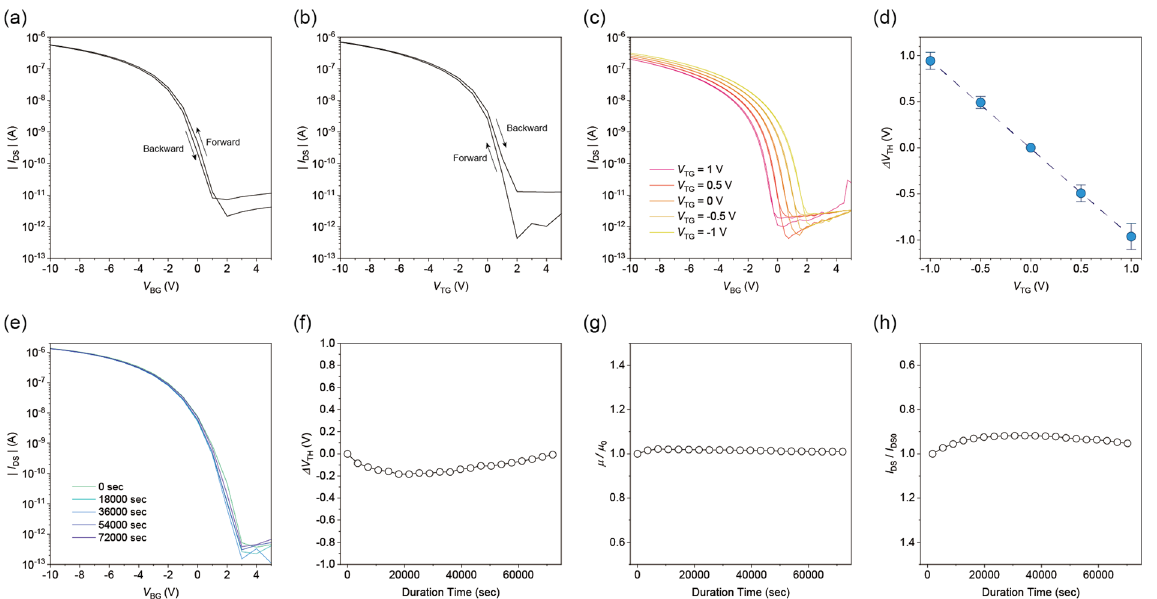
Fig. 2 Basic properties of the fabricated OTFT. | I DS | – V GS curves (transfer characteristics) of the fabricated OTFTs controlled by applying a single-gate voltage at a bottom-gate terminal ( V BG = + 5 to − 10 V) and b top-gate terminal ( V TG = + 5 to − 10 V) ( V DS = – 1 V). c Transfer characteristics of the dual- gate OTFT ( V DS = – 1 V). The applied V TG was – 1, – 0.5, 0, 0.5, or 1 V. d Threshold voltage ( V TH ) dependence with V TG for the bottom-gate OTFT. e Transfer characteristics of the OTFT device taken before and after applying a constant bias voltage for 72,000 s ( = 20 h). f – h Changes in the electrical parameters [( f ) threshold voltage, ( g ) fi eld-effect mobility, and ( h ) drain current] of the fabricated OTFT device under DC bias